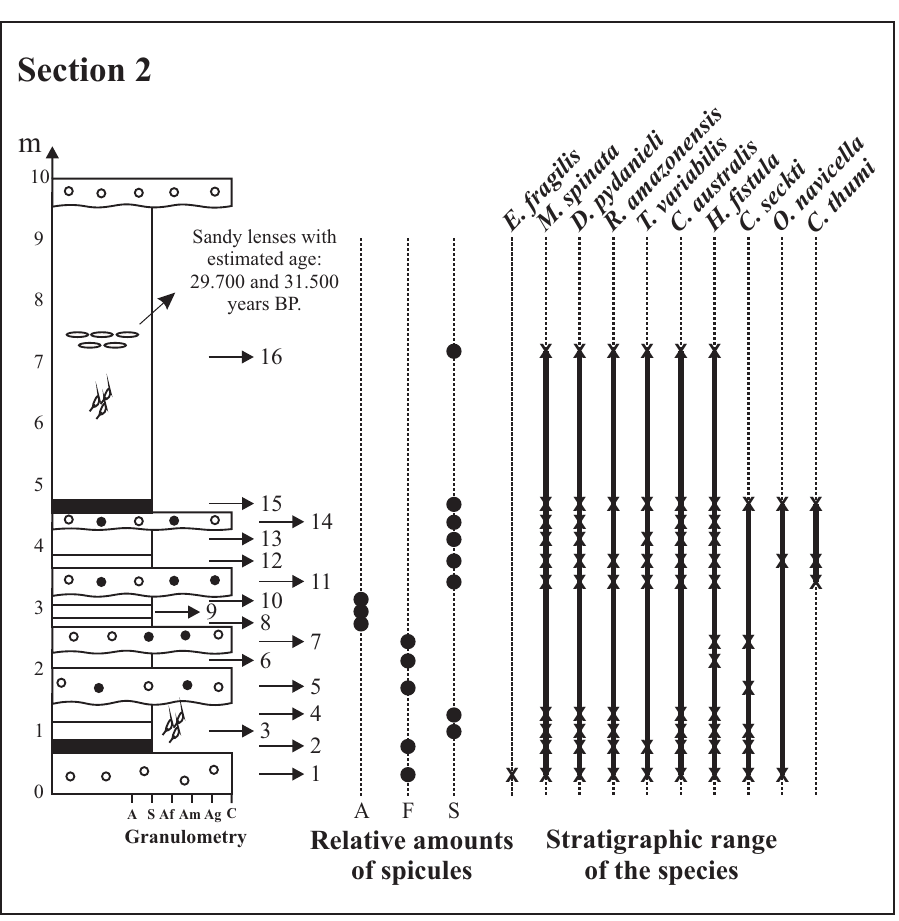
Fig. 7. Profile of Section 2 (meters) vis-a-vis the corresponding relative amounts of sponge spicules (A, absent; F. few; S, spongofacies) and stratigraphic range of the identified species. (X, occurrence of a particular species; A, argillite; S, siltstone; Af, fine sandstone; Am, medium sandstone; Ag, coarse sandstone; C, conglomerate). Legend of rocks as Figure 3. From V.S.M., unpublished